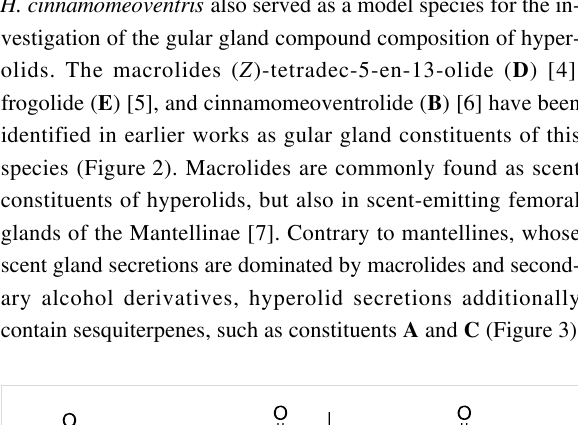
As biological material is scarce and the amount of analytes is low, GC–MS trace analytical methods are performed to investi-